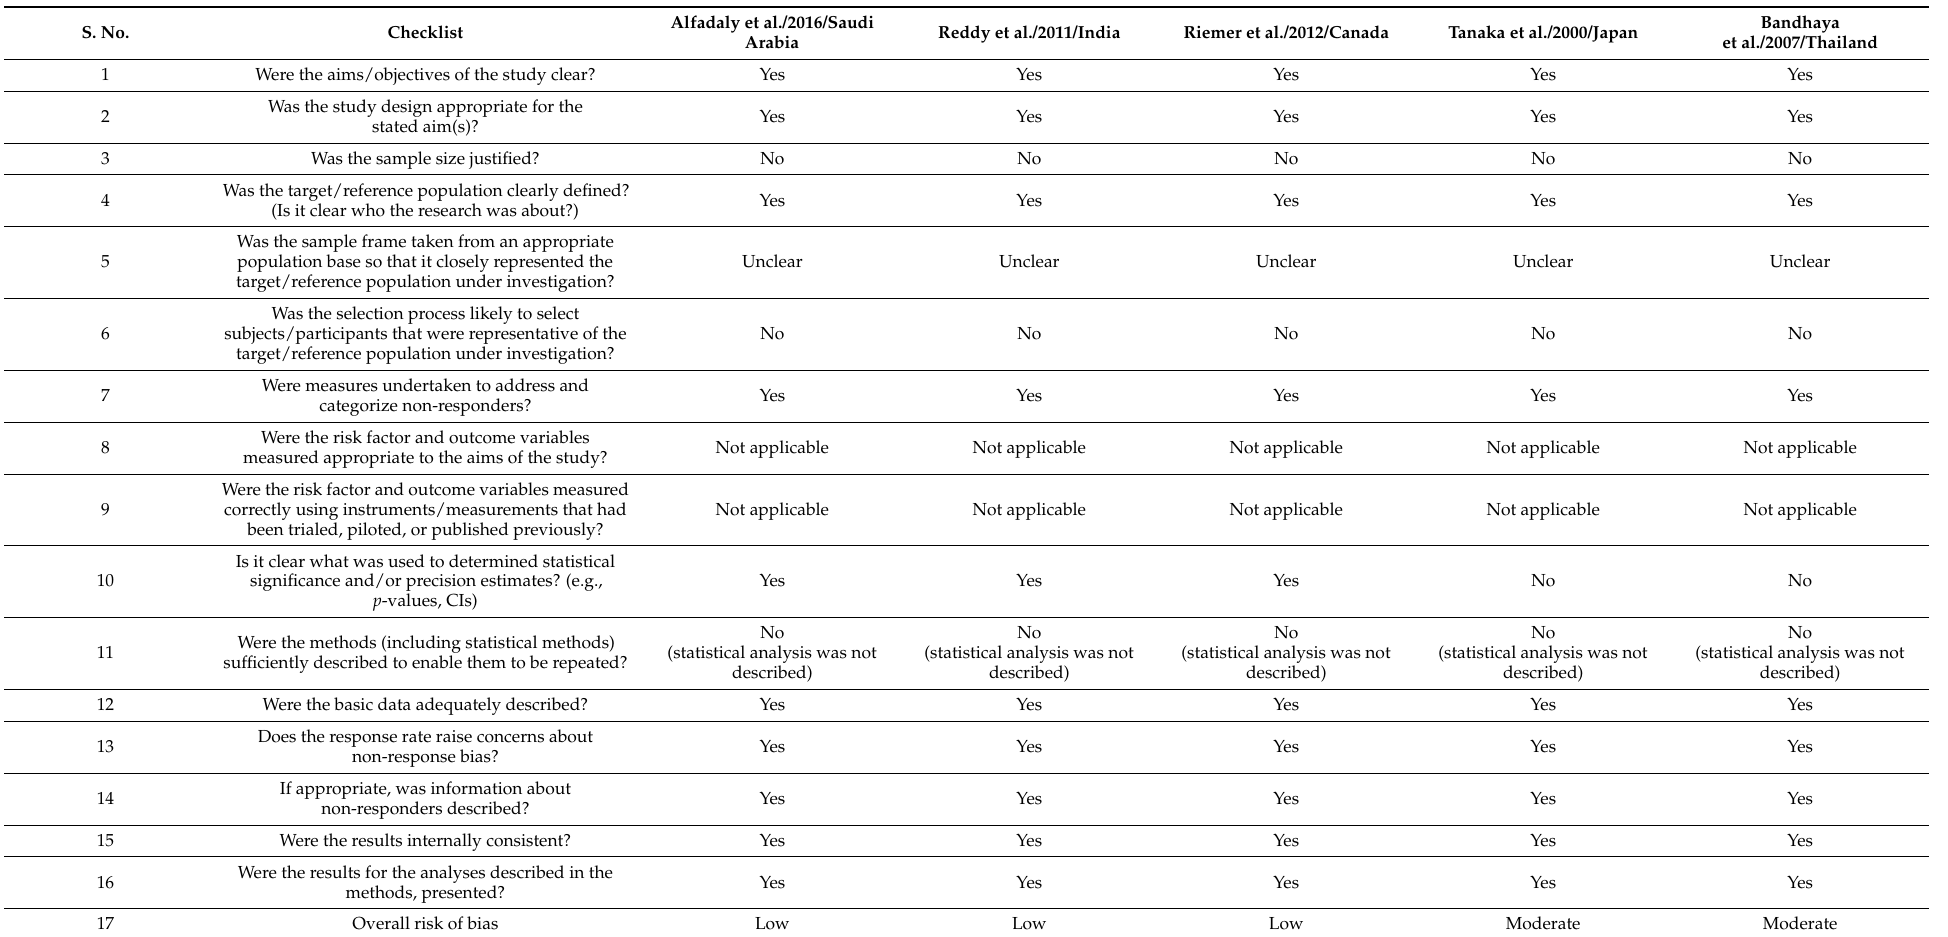
Table 2. Risk of bias of the included